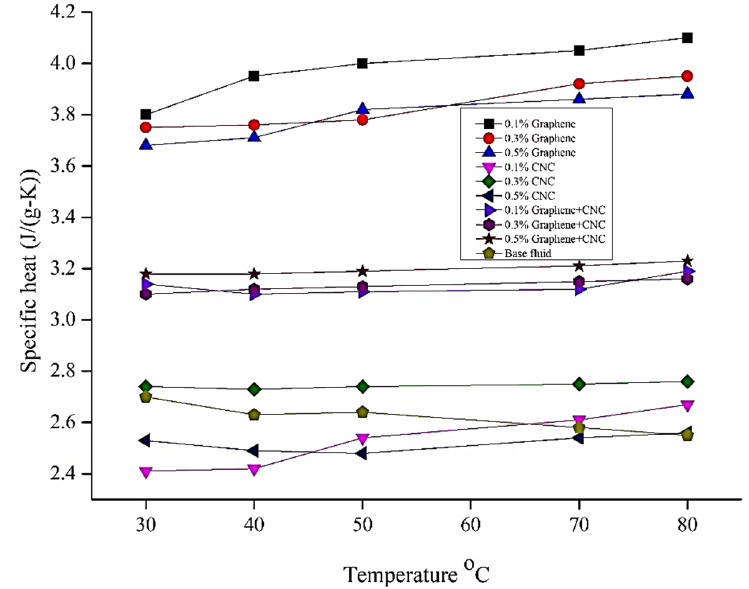
Figure 15. Assessment of the temperature correlated specific heat of the nanofluids graphene, CNC, and (hybrid graphene+CNC).